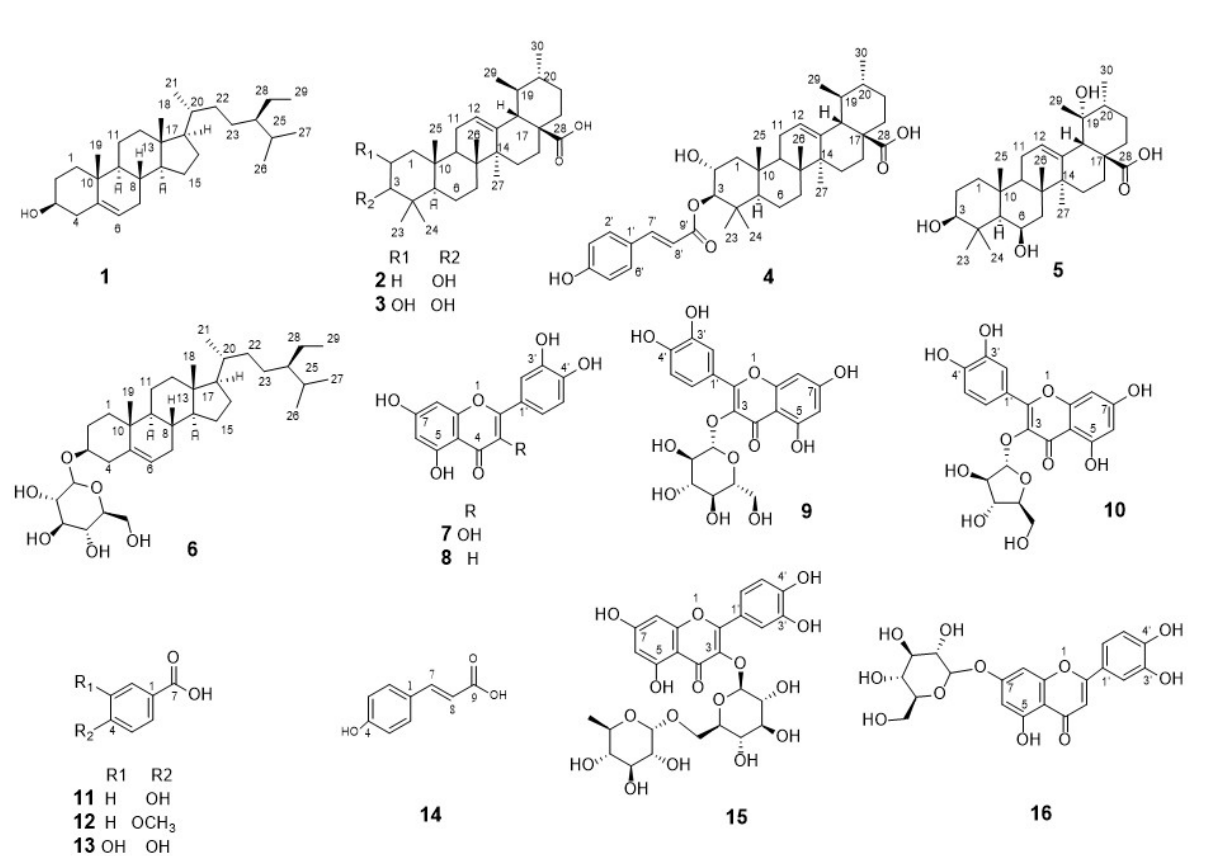
Figure 2. The chemical structures of the isolated compounds from T. guayacan Hemsl. Table 1. Docking protocols for each macromolecule